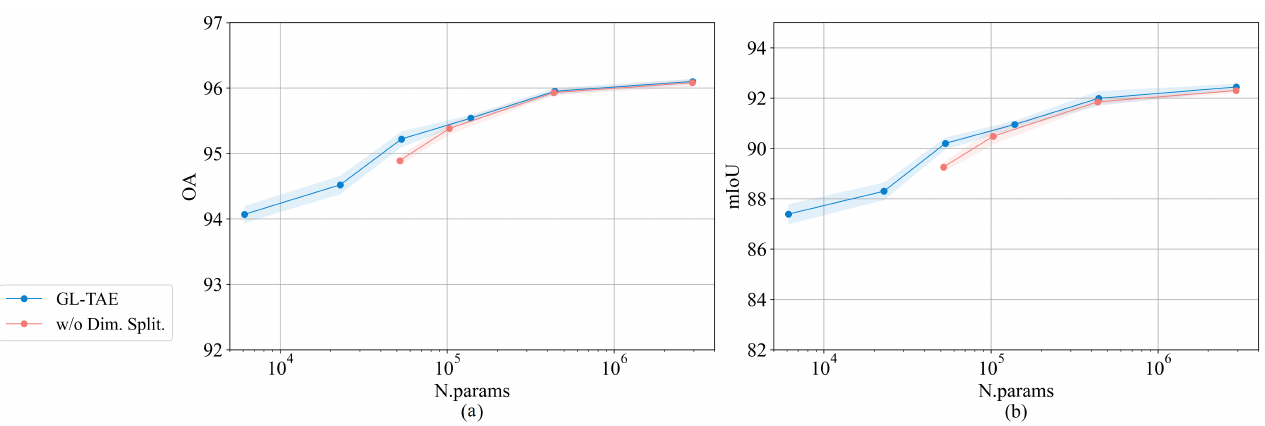
Figure 8. Performance of ( a ) OA and ( b ) mIoU on the TiSeLaC of GL-TAE with/without Dim. Split ; plotted with respect to the parameter numbers. GL-TAE without Dim. Split has four hyperparameter settings corresponding with the second to fifth hyperparameter settings of GL-TAE with Dim. Split .